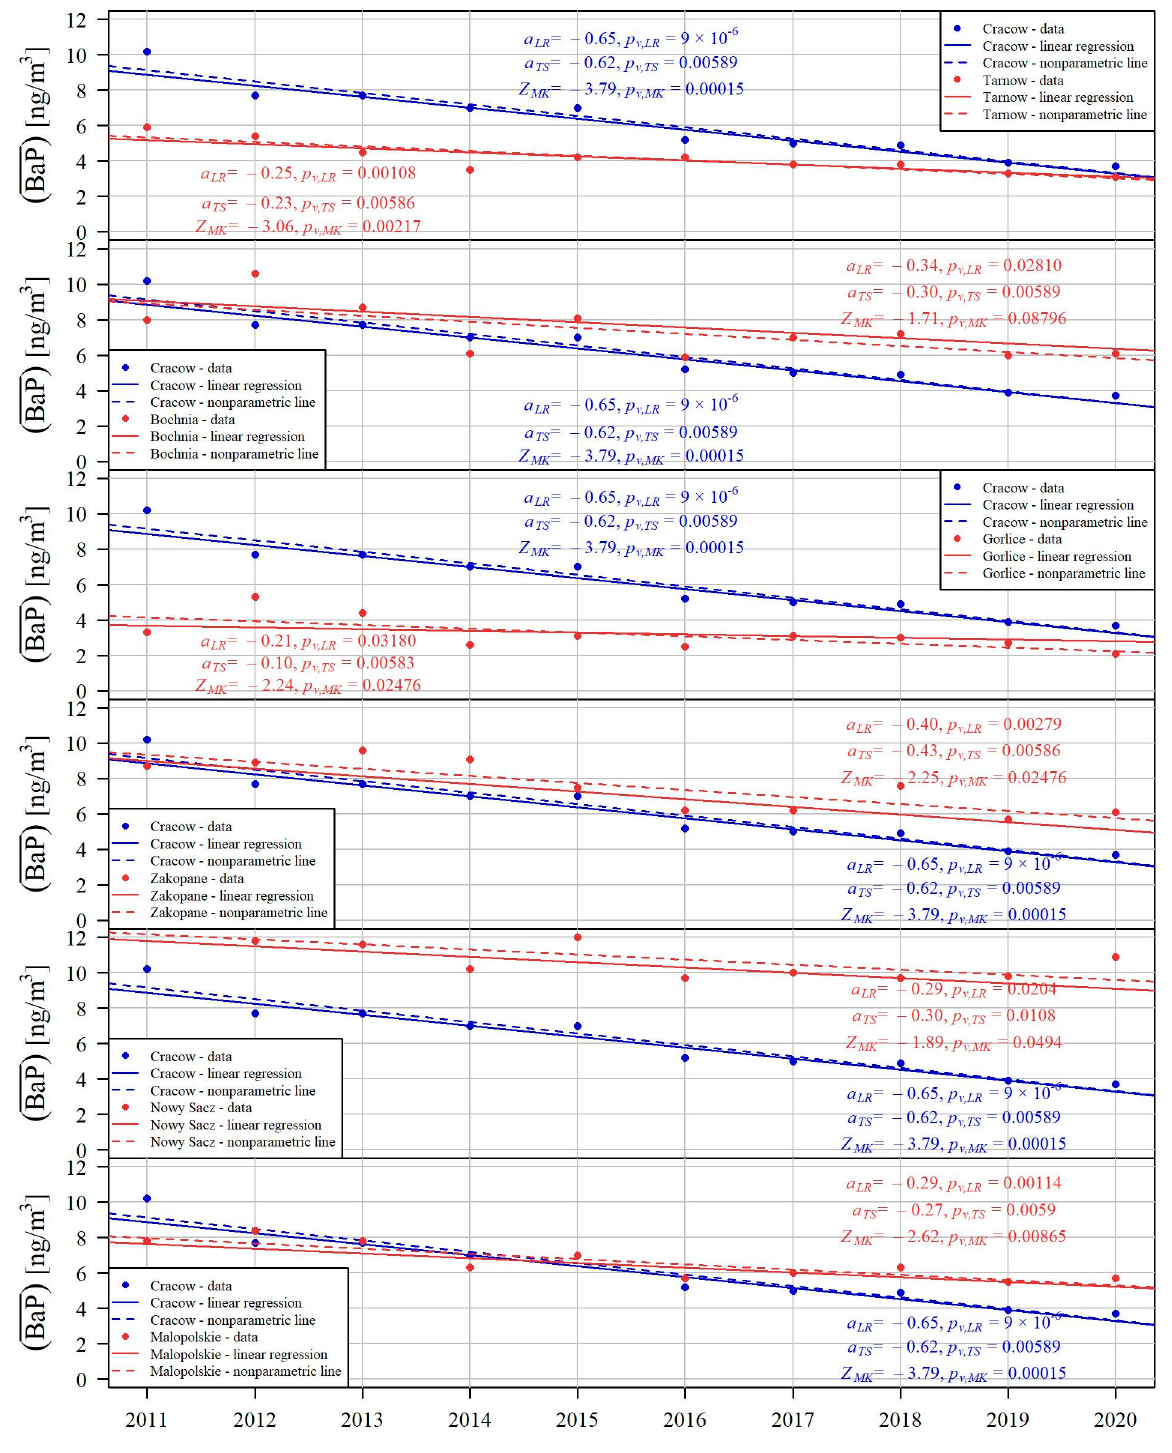
Figure 5. Comparison of the distributions of average annual concentrations of BaP (PM10) in Cracow and the analyzed cities of the Malopolskie Voivodeship in 2011–2020. Significant ( p v , MK < 0.05) decreasing trends shown using Theil–Sen line with significant slope a TS [ n g/m 3 /year] ( p v,TS < 0.05). Linear regressions with significant a LR [µg/m 3 /year] ( p v , LR < 0.05) are shown for comparison. Malopolskie means the arithmetic mean of the values for individual analyzed cities, excluding Cracow. (Source: own elaboration based on the data from the database of the Chief Inspectorate for Environmental Protection [29]).